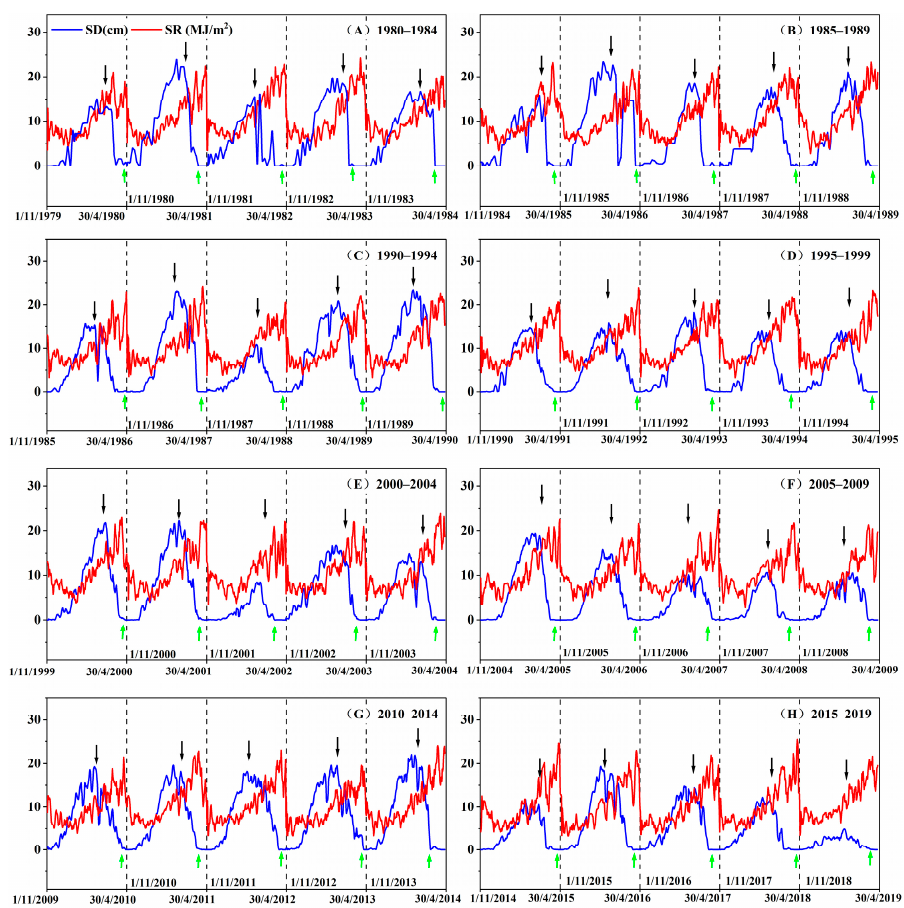
Figure 2. ( A – H ) Relationship between solar radiation (SR) and snow depth (SD) from November to April in the year after during 1980–2019. The black arrows indicate the time when the minimum snowmelt factor occurs. The green arrows indicate the time when the maximum snowmelt factor occurs.